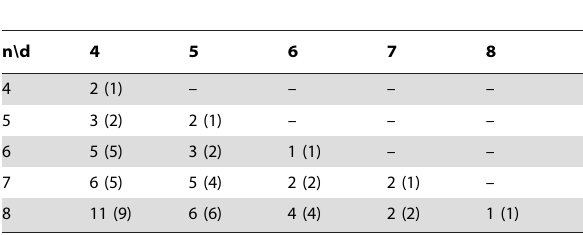
Table 3. Size values to satisfy different combinatorial constraints.